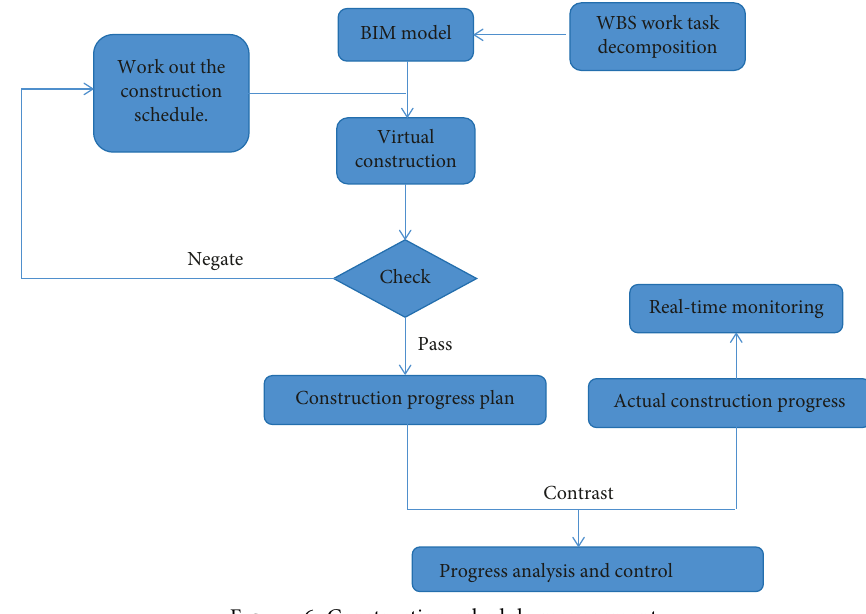
Figure 6: Construction schedule